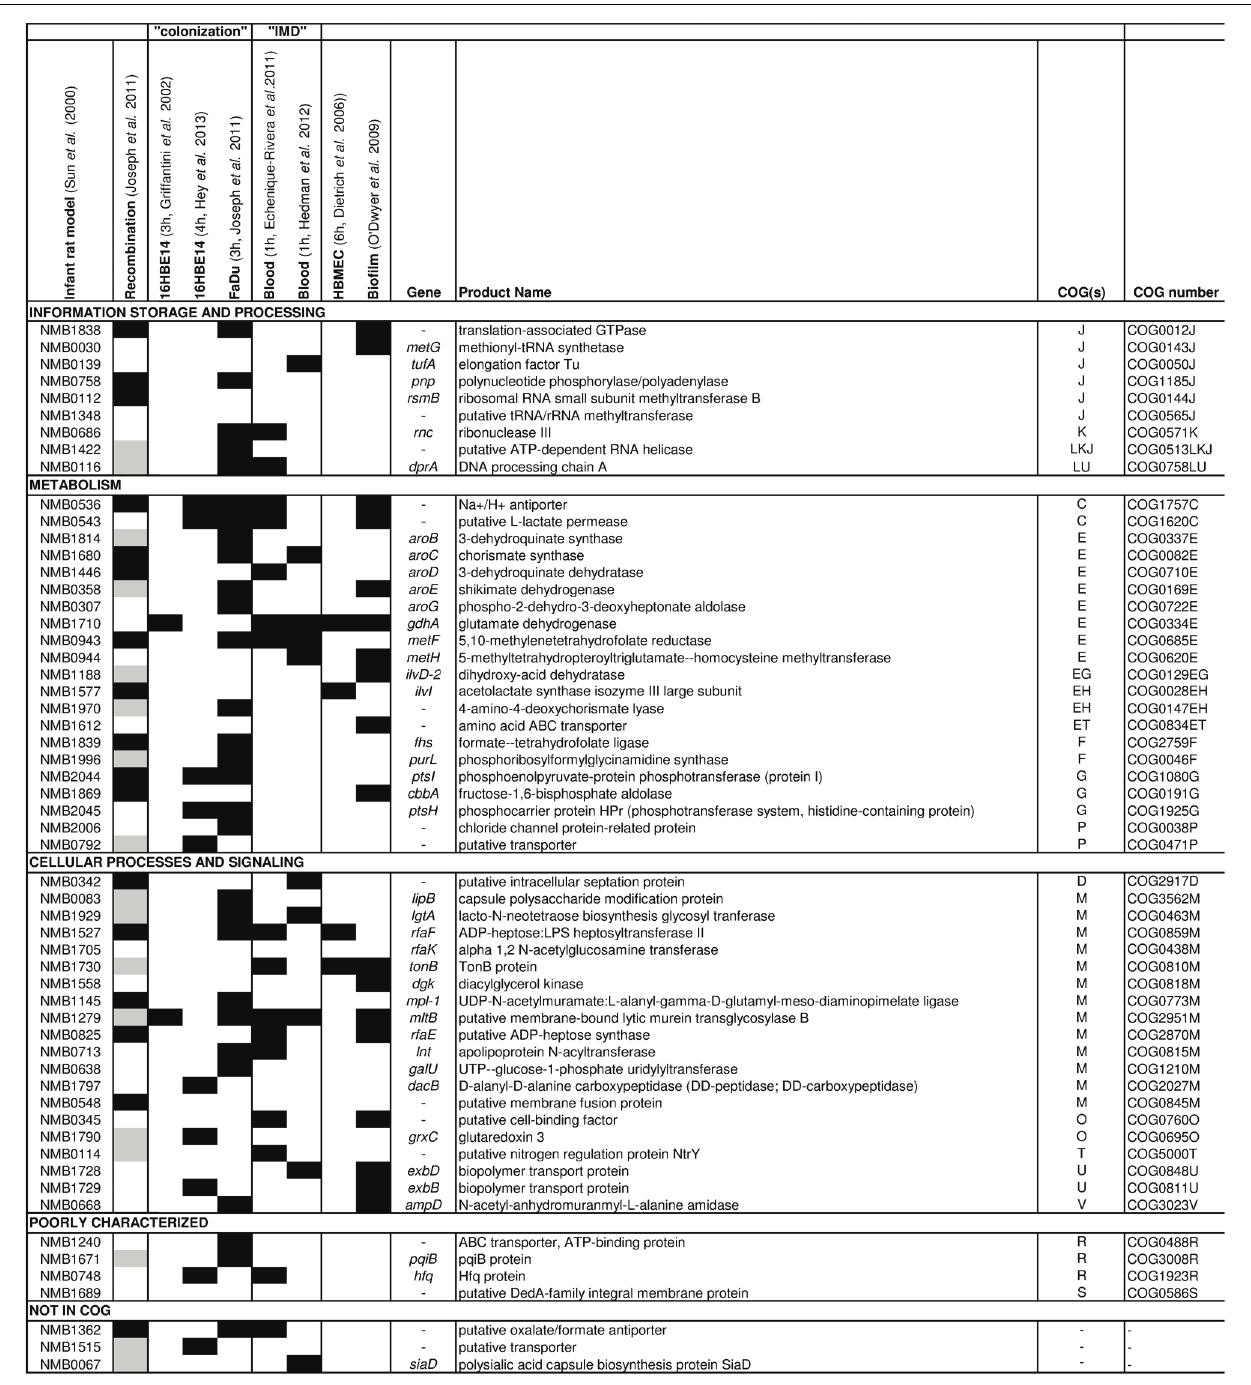
in human whole blood after 1h taken from Echenique-Rivera et al. (2011) and from Hedman et al. (2012), respectively, upon adhesion to human brain microvascular endothelial cells after 6h (Dietrich et al., 2003) and in cells grown in biofilm vs. planctonic culture (O’Dwyer et al., 2009). Black boxes indicate that the respective gene was identified in the corresponding study, and gray boxes indicate that the gene was not included in the study considered. The last column gives the COG functional assignment for each gene (Tatusov et al., 2001) (for COG abbreviations see legend to Figure 2 ).